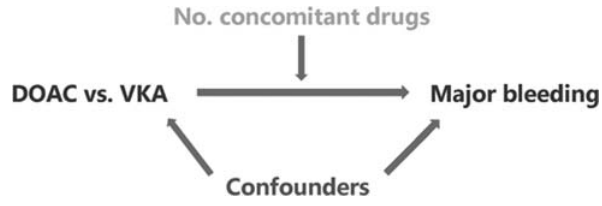
Fig. 2 The relation between the exposure, primary outcome, effect modi fi er (the number of concomitant drugs, primarily of interest in this study), and